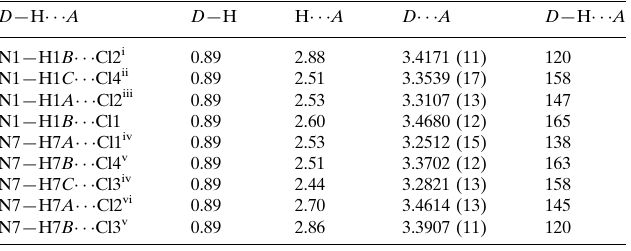
Hydrogen-bond geometry (A˚ , (cid:3)